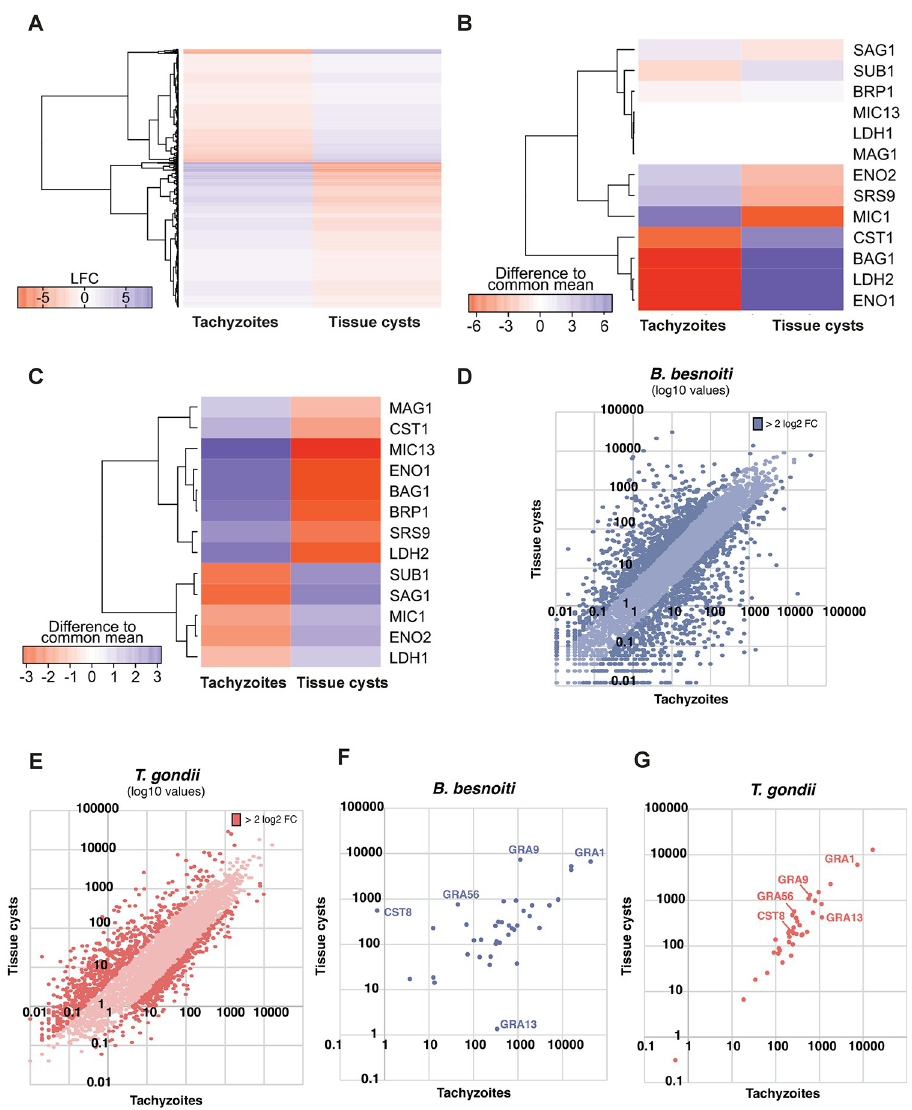
Fig 7. Differential expression of mRNA between B . besnoiti tachyzoites and tissue cysts and comparison to T . gondii . (A) Heatmap depicting log 2 fold changes (LFC) of the top 10% of differentially expressed genes. N = 1172 (B) Heatmap showing the differences to the common mean (Z-score) of B . besnoiti orthologues of typical stage marker genes known in T . gondii . Tachyzoites (Z < 0, red) and tissue cysts (Z > 0, purple). (C) Heatmap showing the differences to the common mean (Z-score) of T . gondii tissue cyst-specific genes. (D) Scatter plot of TPM (Transcripts Per Kilobase Million, ToxoDB release 52) values of expressed genes in B . besnoiti . Values for tachyzoites are plotted against TPMs from tissue cysts. (E) Scatter plot of TPMs (ToxoDB release 52) values of protein coding genes in T . gondii . (F) Scatter plot with TPMs depicting genes encoding expressed dense granule proteins in B . besnoiti . (G) Scatter plot with TPMs depicting syntenic T . gondii genes from figure (F). BAG1: bradyzoite antigen 1; BPK1: bradyzoite pseudokinase 1; BRP1: bradyzoite rhoptry protein 1; CST: cyst wall protein; ENO: enolase; LDH: lactate dehydrogenase; MAG: matrix antigen; MIC: micronemal protein; SAG: surface antigen; SRS: SAG-related sequence; SUB: